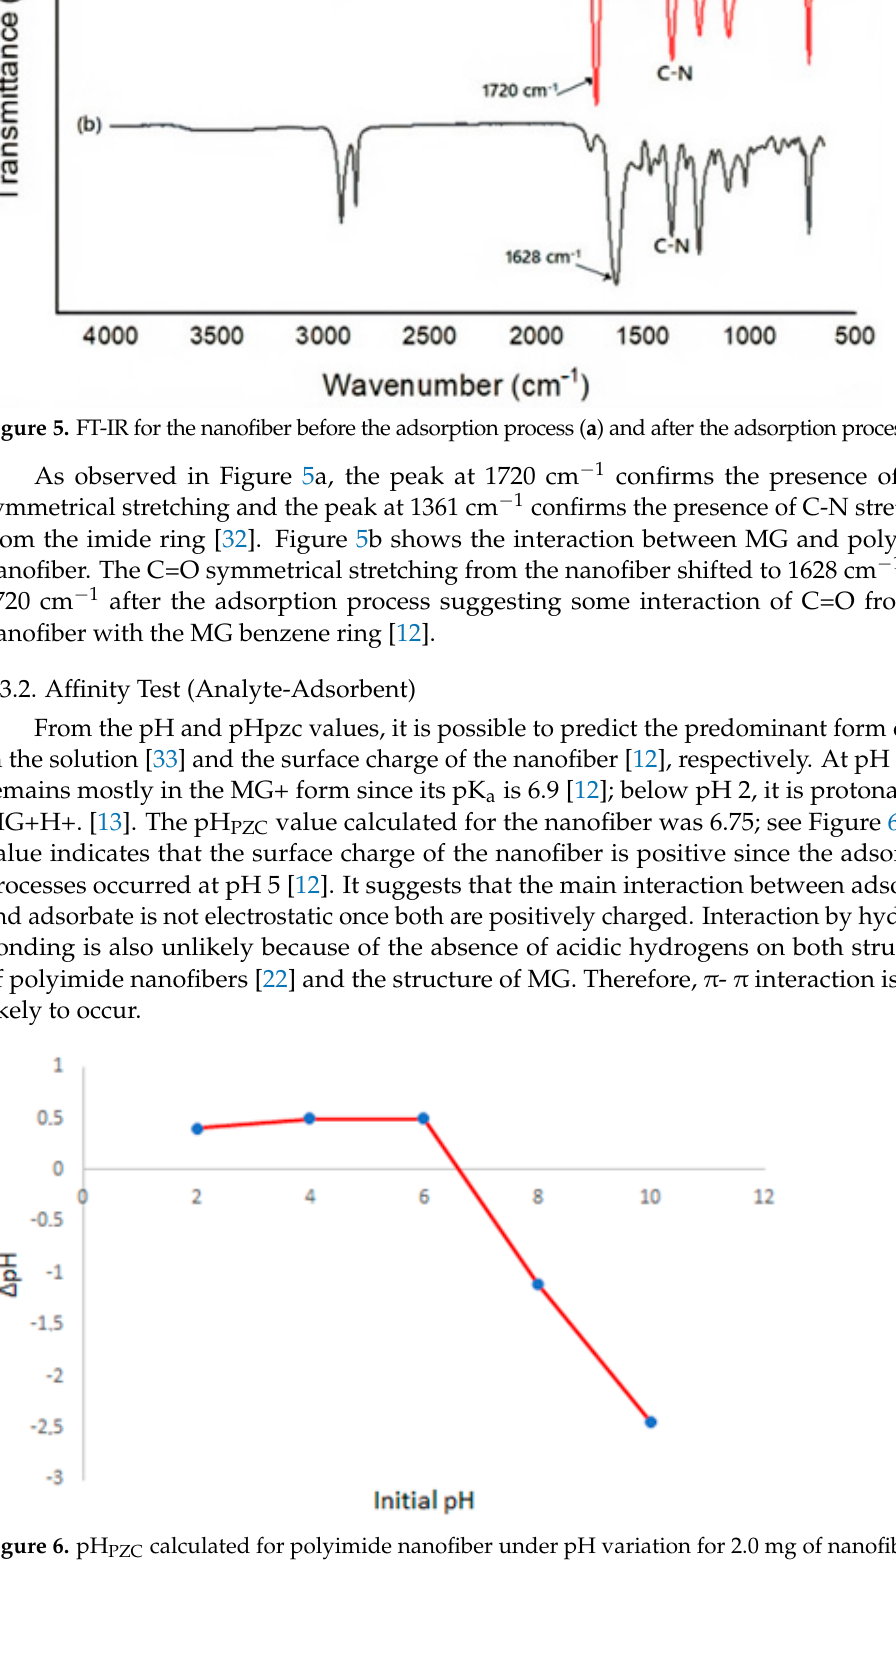
Figure 7. Molecular structures of polyimide nanofiber and MG. Examples of possible different ways of adsorption through π - π interaction by carbon from aromatic amine ( a ) and benzene rings ( b ). 3.3.3. Adsorption Isotherms In order to make a better sense of the adsorption process, two adsorption models were studied. The isotherms for each model are presented in Figure 8 and the parameters for each model are shown in Table 1. Table 1. Parameters for adsorption of malachite green to polyimide nanofiber. Model